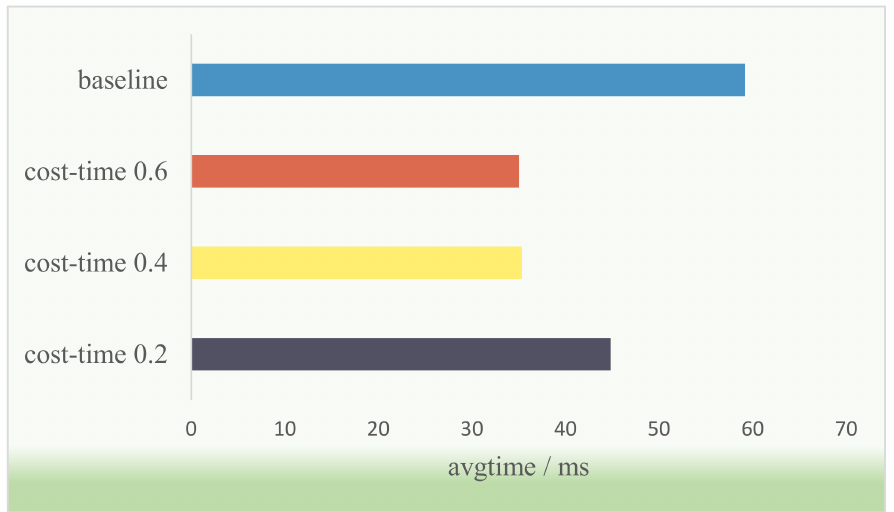
Figure 10. Average recognition time.